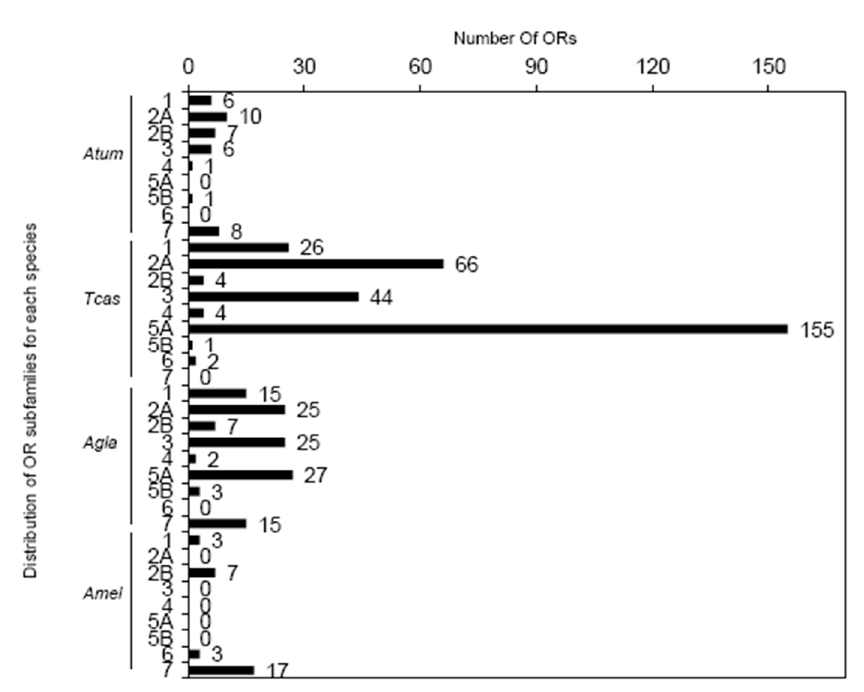
Figure 3. Distribution and count of odorant receptors (ORs) among OR subfamilies. The numbers or numbers with letters on the right of the y-axis (1, 2A, 2B, 3, 4, 5A, 5B, 6, and 7) represent the nine major OR subfamilies. The numbers on the right of the bars indicate the number of ORs for each gene subfamily. Atum, Tcas, Agle, and Amel stand for Aethina tumida , Tribolium castaneum , Anoplophora glabripennis , and Apis mellifera , respectively.